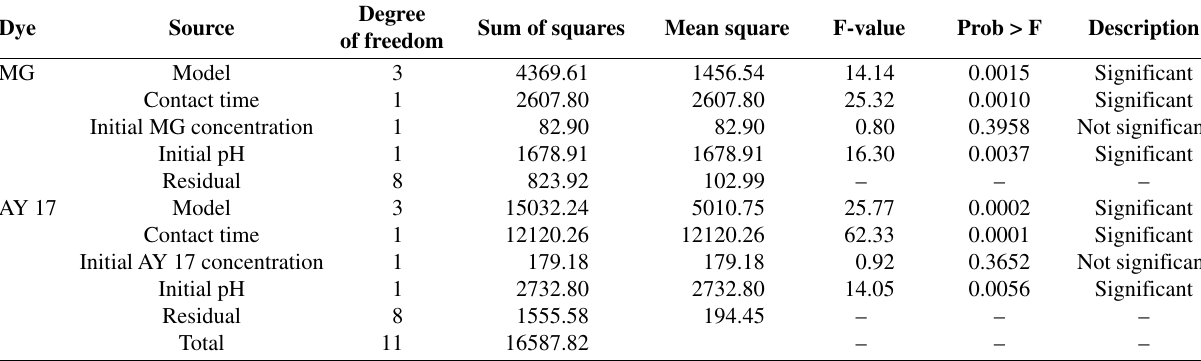
Table 5. Regression analysis (ANOVA) of Placktt-Burman of MG and AY 17 in binary dye solution